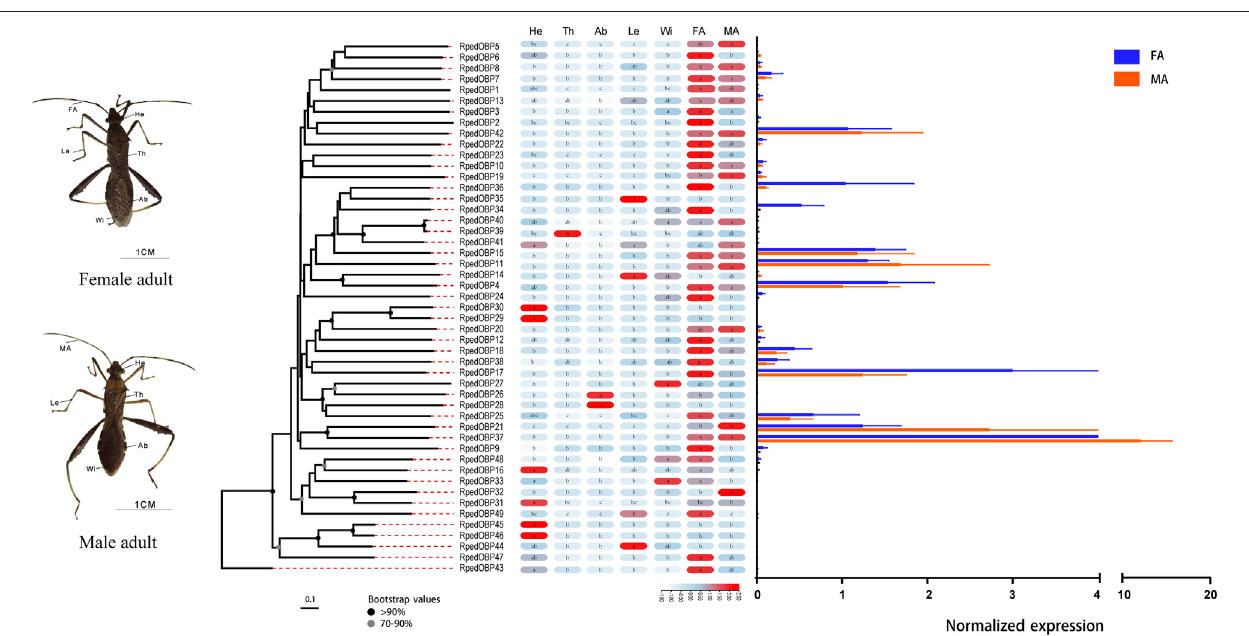
FIGURE 6 | Tissue expression pro fi les of R. pedestris OBPs by qRT-PCR. The relative expression level is presented as mean ± SE ( n = 3). The heatmap use Log2 and row scale based the relative expression level data. Different capital letters mean a signi fi cant difference between tissues ( p < 0.05, ANOVA, LSD). He, heads; Th, thoraxes; Ab, abdomens; Le, legs; Wi, wings; FA, female antennae; MA, male antennae.